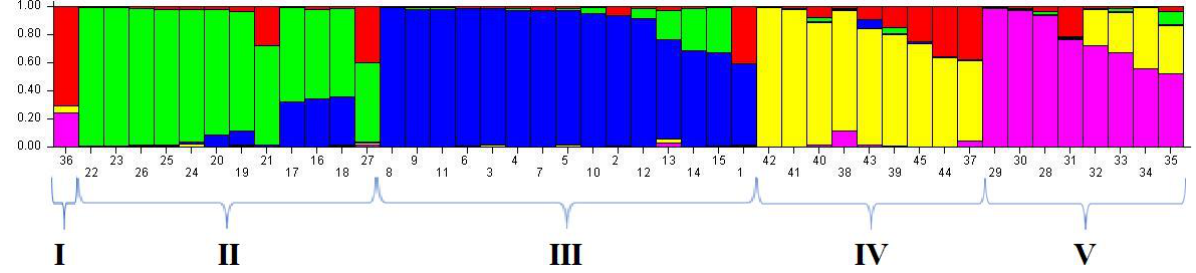
Figure 4. Genetic structure of varieties according to iPBS data (the bean varieties given in K = 5